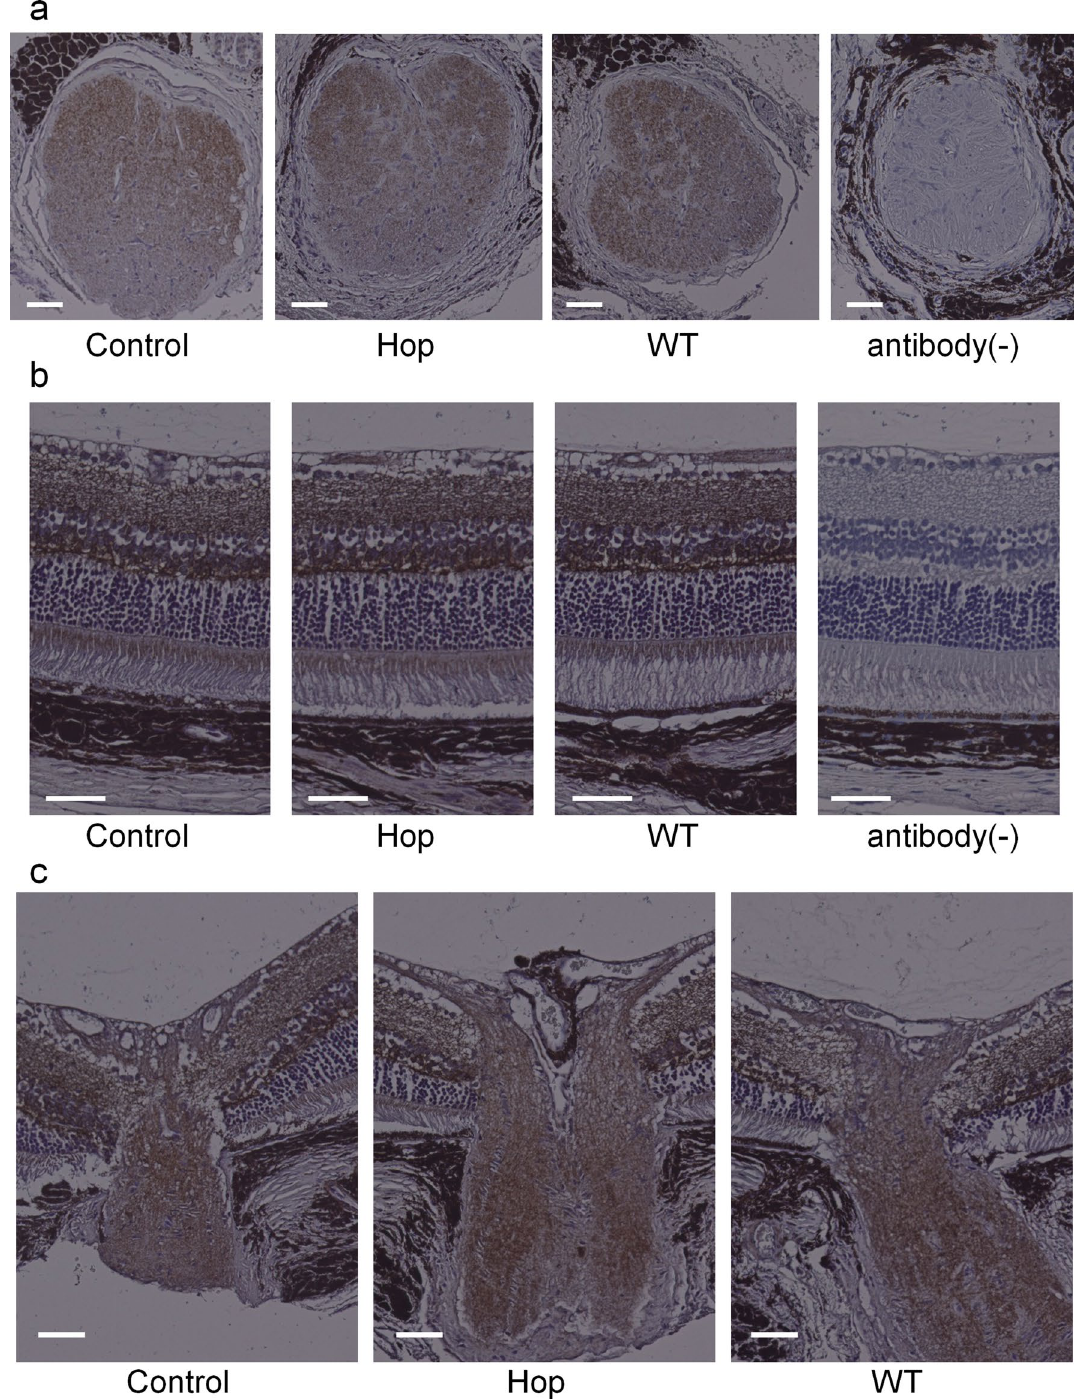
Figure 5. Amyloid β immunostaining of optic nerve cross sections and retinal sections in GLAST (+/−) mice treated with or without hop extracts and GLAST (+/+, wild type) mice. Optic nerve cross sections and retinal sections of 18-month-old GLAST (+/−) mice administered with hop extracts or water as a control and GLAST wild type (WT) mice were stained with or without the presence of anti-amyloid β antibody. ( a ) Optic nerve cross sections. ( b ) Retinal sections. ( c ) Optic nerve vertical sections. Bars represent 50 µm in ( a – c